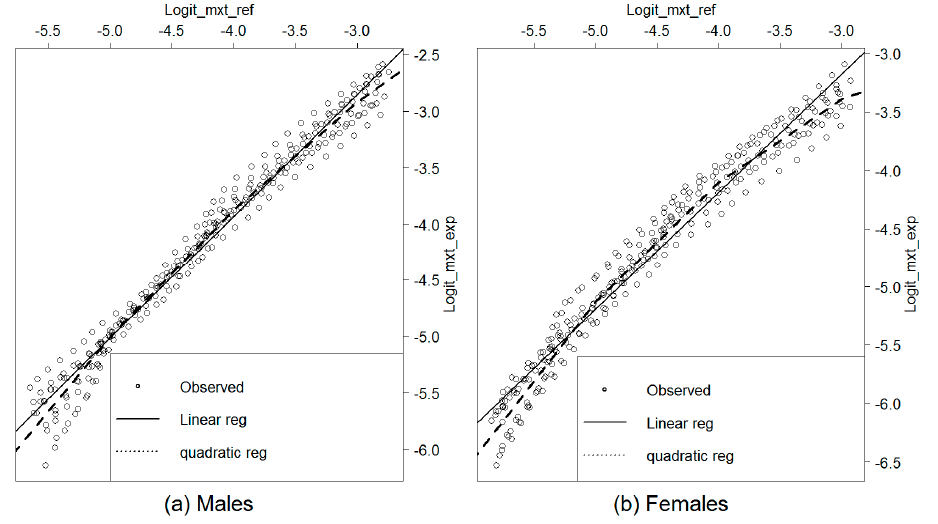
Figure 13. Logit-quadratic regression model vs. Logit-linear regression model.